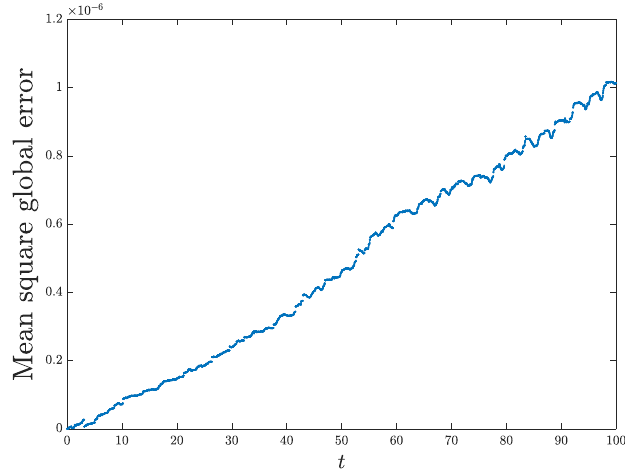
Figure 6. Convergence order for Example 2.